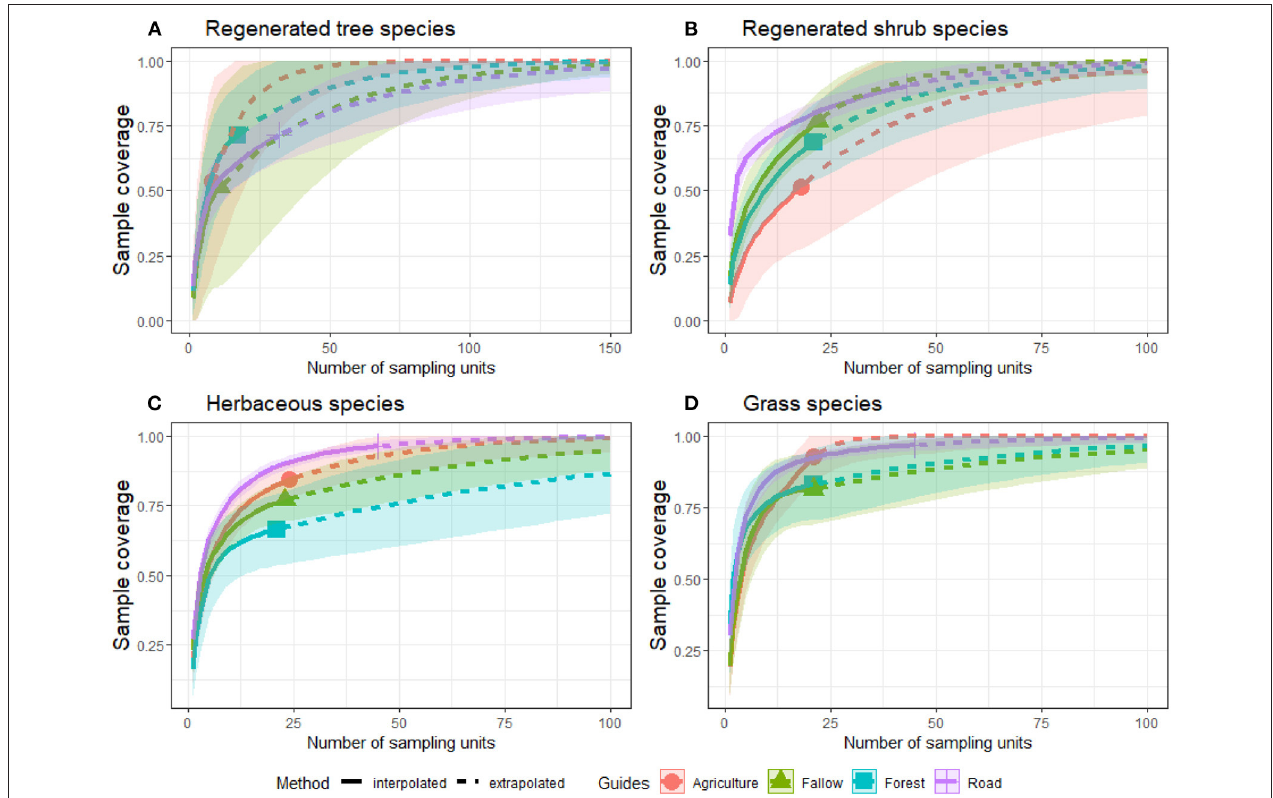
FIGURE 3 | Sample-based interpolation and extrapolation for sample coverage compared to plant life forms (A–D) across land-uses in Moribane Forest Reserve, central